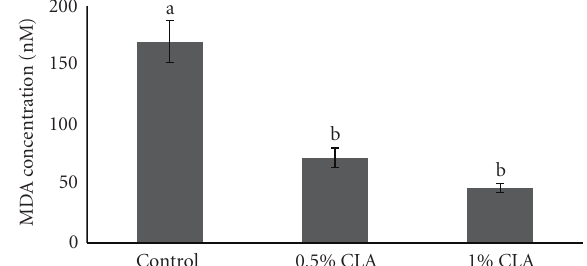
Figure 2: Liver MDA levels in mice fed diets containing 0 (control), 0.5%, or 1% CLA for 2 weeks. Values are means ± SEM; N = 4 to 6 in each group. Means with a di ff erent letter are significantly di ff erent, P < .